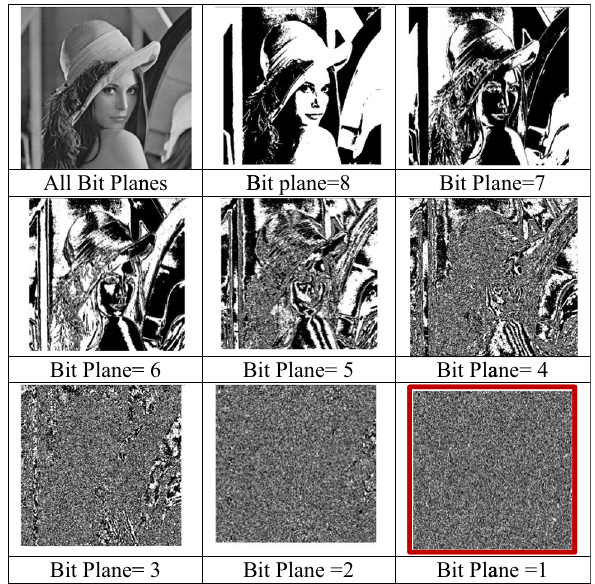
Figure 4: The 8 bit planes of the gray scale